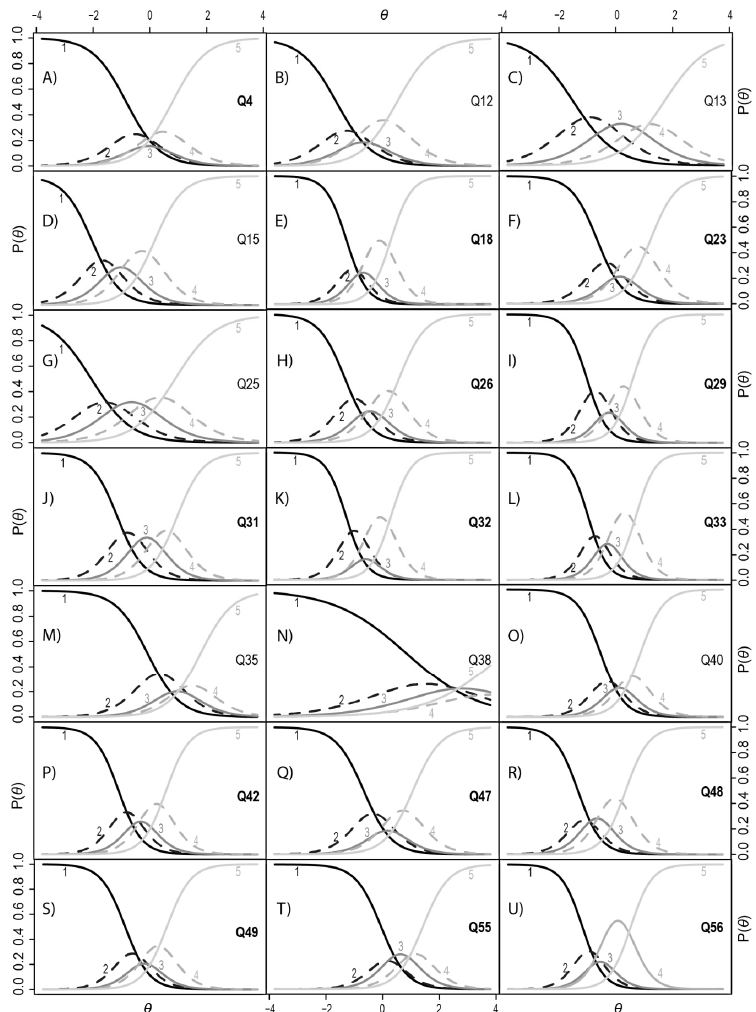
Figure 2. Trace curves for the items of MisoQuest. Items added to the final questionnaire are in bold (i.e., Q4). The functions describe, in probabilistic terms, how likely a person with a higher standing on a trait ( θ ) is to provide a response in a di ff erent category to a person with a low standing on the trait. There are 21 plots, one for each item. Five curves on the plot represent each possible response to the item. Curve 1 represents the response “strongly disagree”, curve 2 the response “disagree”, curve 3 the response “neither agree nor disagree”, curve 4 the response “agree” and curve 5 the response “strongly agree”. The person’s misophonia level is denoted by θ , and is plotted along the horizontal axis. The vertical axis shows the probability P( θ ) of each response given the person’s level of misophonia. The curve for option 1 is high at the lowest ability levels and gradually declines with higher levels of misophonia. Similarly, the probability of response 5 is very small at low misophonia levels ( θ ) but rises as θ increases. The probability of the other options rises with θ to a certain point and then declines